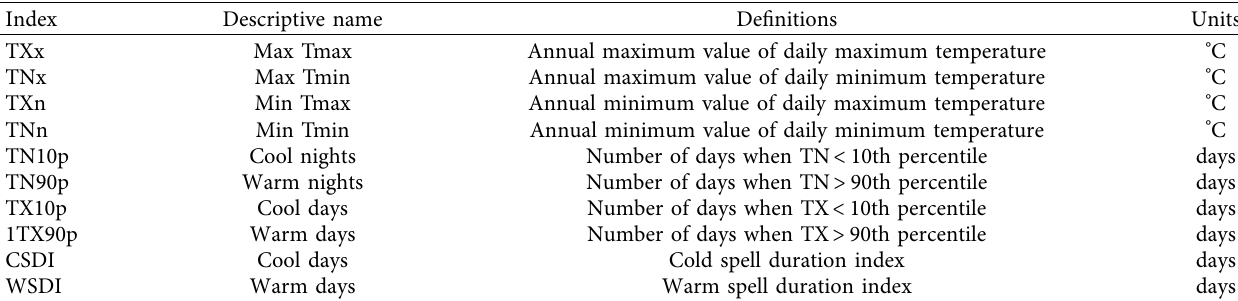
Table. 1: List of ETCCDMI temperature indices.